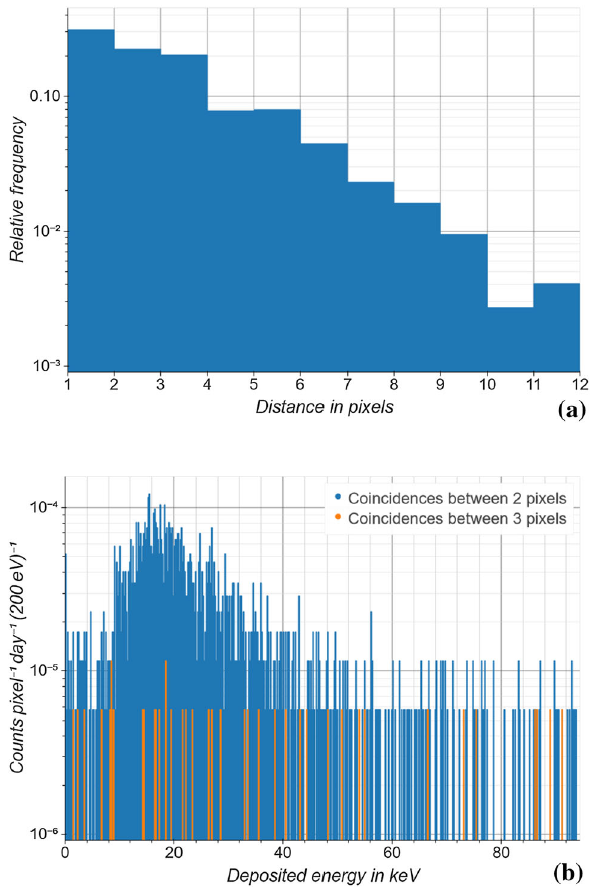
Fig. 6 a Simulated relative frequency of distances between coinciden- tal pixels. The drop at the distance of 4 is caused due the alignment of the pixel array of 4 × 18 pixels. b Coincidental events of the simu- lated spectrum of the deposited energies in the detector pixels for a multiplicity of 2 (blue) and 3